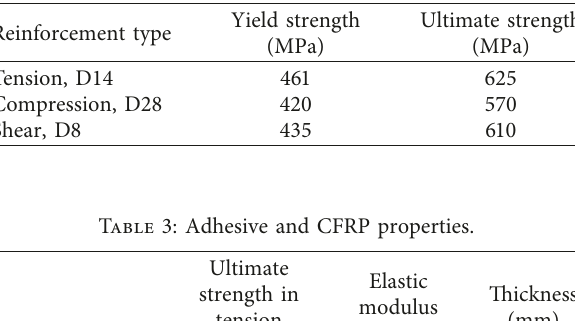
Table 2: Materials’ properties of steel reinforcement.